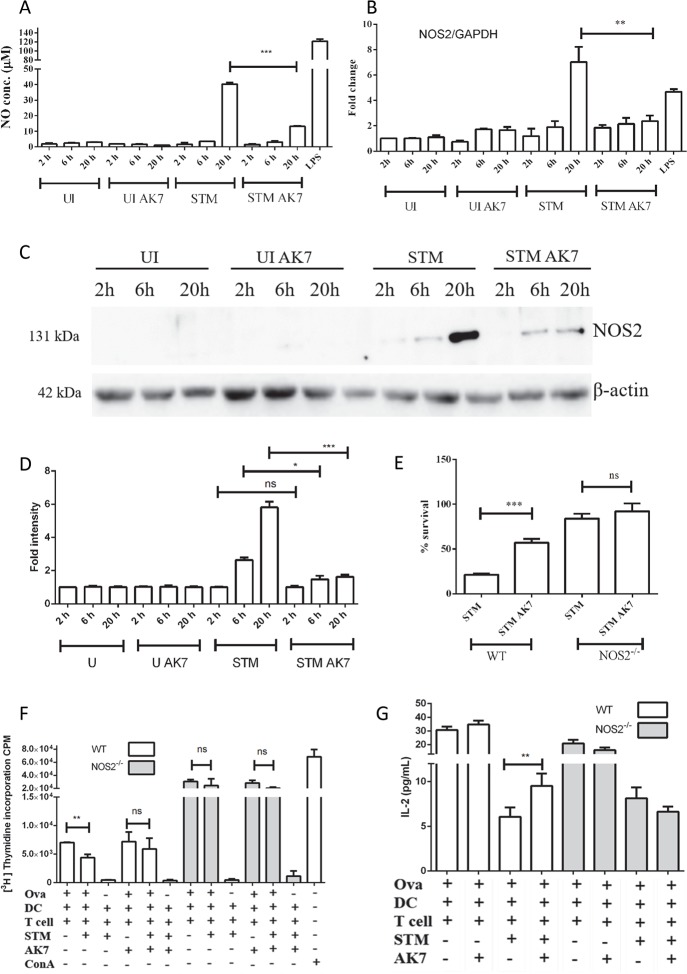
Effect of SIRT2 inhibition is nitric oxide mediated.A. Nitric oxide levels in conditioned media in response to SIRT2 inhibition at indicated time post infection. (UI- uninfected DCs, UI AK7- Uninfected DCs treated with 10 μM AK7, STM- Salmonella Typhimurium infected DCs, STM AK7- - Salmonella Typhimurium infected DCs treated with 10 μM AK7) (Data are presented as mean ± SEM of 5 independent experiments). B. qPCR analysis of NOS2 expression in DCs at indicated time post infection in response to SIRT2 inhibition. GAPDH was used as an internal control. (UI- uninfected DCs, UI AK7- Uninfected DCs treated with 10 μM AK7, STM- Salmonella Typhimurium infected DCs, STM AK7- Salmonella Typhimurium infected DCs treated with 10 μM AK7, LPS- 100 ng/ml LPS treated). (Data are presented as mean ± SEM of 3 independent experiments). C. Representative immunoblot of NOS2 in the presence and absence of SIRT2 inhibition at indicated time. (UI- uninfected DCs, UI AK7- Uninfected DCs treated with 10 μM AK7, STM- Salmonella Typhimurium infected DCs, STM AK7- Salmonella Typhimurium infected DCs treated with 10 μM AK7) D. Densitometry analysis of NOS2 level in the presence and absence of SIRT2 inhibition at indicated time. (UI- uninfected DCs, UI AK7- Uninfected DCs treated with 10 μM AK7, STM- Salmonella Typhimurium infected DCs, STM AK7- Salmonella Typhimurium infected DCs treated with 10 μM AK7) (Data are presented as mean ± SEM of 3 independent experiments). E. Percentage survival of intracellular Salmonella in DCs in gentamicin protection assay in the presence and absence of SIRT2 inhibitor in wild type and NOS2-/- DCs. (Mock- DMSO treated, AK7- 10 μM AK7 treated). (Data are presented as mean ± SEM of 4 independent experiments) F. 3[H] Thymidine incorporation assay to assess CD8+ T cells proliferation during Salmonella infection in wild type and NOS2-/- DCs in the presence and absence of SIRT2 inhibition. (Ova- Ovalbumin, DC- Dendritic cells, T cell- mixed lymphocyte, STM- Salmonella Typhimurium, ConA- Concanavalin A) (Data are presented as mean ± SEM of 3 independent experiments) G. IL-2 levels during CD8+T cells proliferation assay in response to Salmonella infection in wild type and NOS2-/- DCs. (Ova- Ovalbumin, DC- Dendritic cells, T cell- mixed lymphocyte, STM- Salmonella Typhimurium) (Data are presented as mean ± SEM of 2 independent experiments) (unpaired two tailed Student’s t- test, p- value, *** < 0.0001, **<0.001, *<0.01).